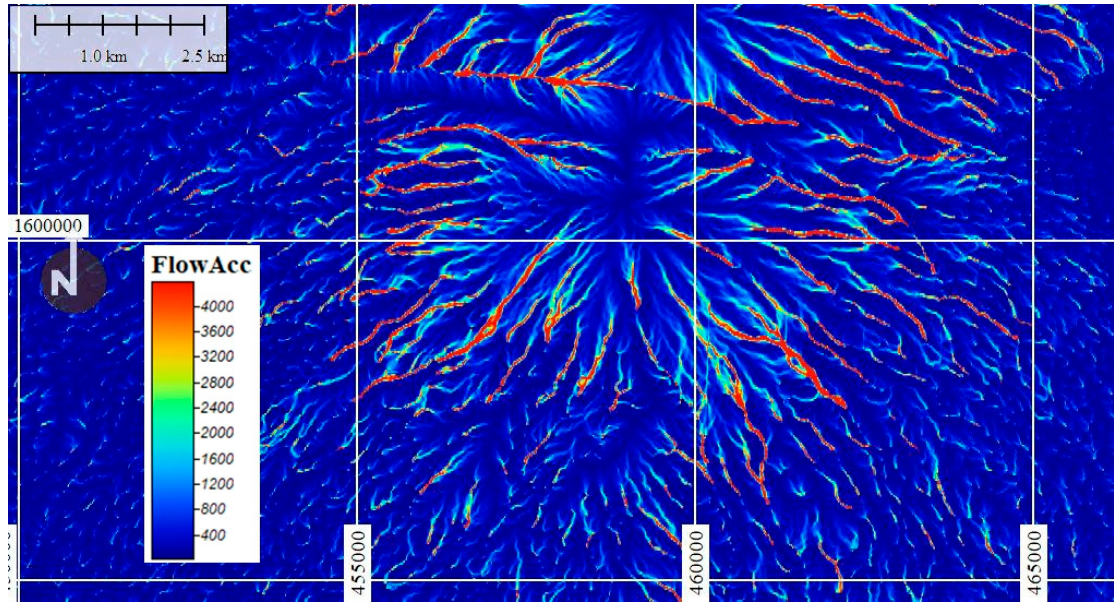
Figure 11. Cumulative flow calculated in SAGA GIS. The higher values (tendency to red color) 432